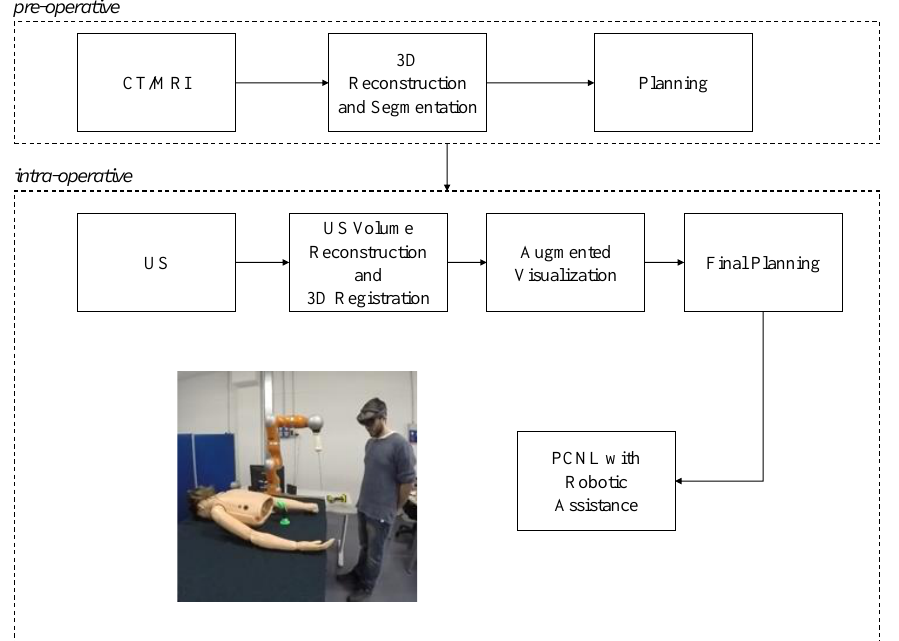
Figure 4. A possible architecture implementing the integration between augmented reality and robotic assistance for PCNL